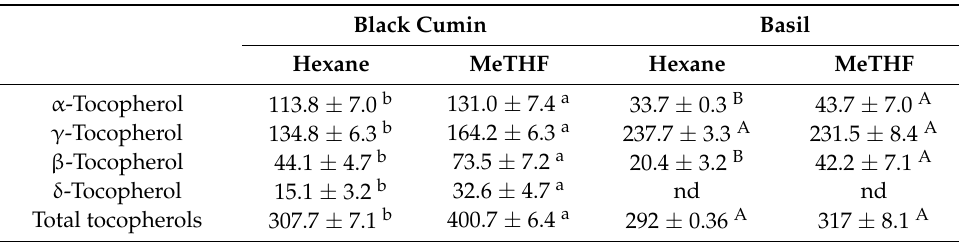
Table 3. Composition of tocopherols (mg/kg of oils) in black cumin and basil seed oils after extraction by hexane and MeTHF. Black Cumin Basil Hexane MeTHF Hexane MeTHF α